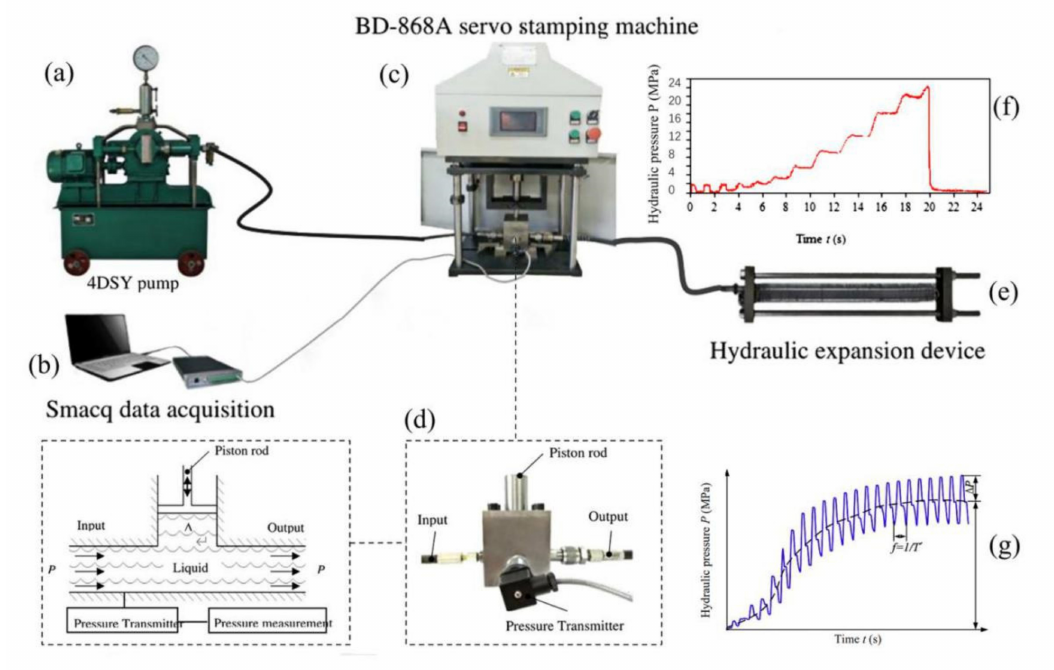
Figure 5. Non-pulsating and pulsating hydraulic expansion experimental platform. ( a , d ) External pressure liquid supply device; ( b ) data acquisition system; ( c ) stamping machine; ( e ) self-designed hydraulic expansion device; ( f ) non-pulsating hydraulic pressure; ( g ) pulsating hydraulic